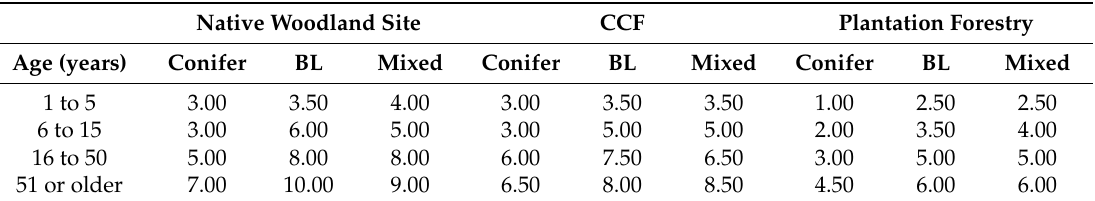
Table A12. Forest recreational scores for a range of forest types. Source: Edwards, Jay, Jensen, Lucas, Marzano, Montagné, Peace and Weiss [42]).